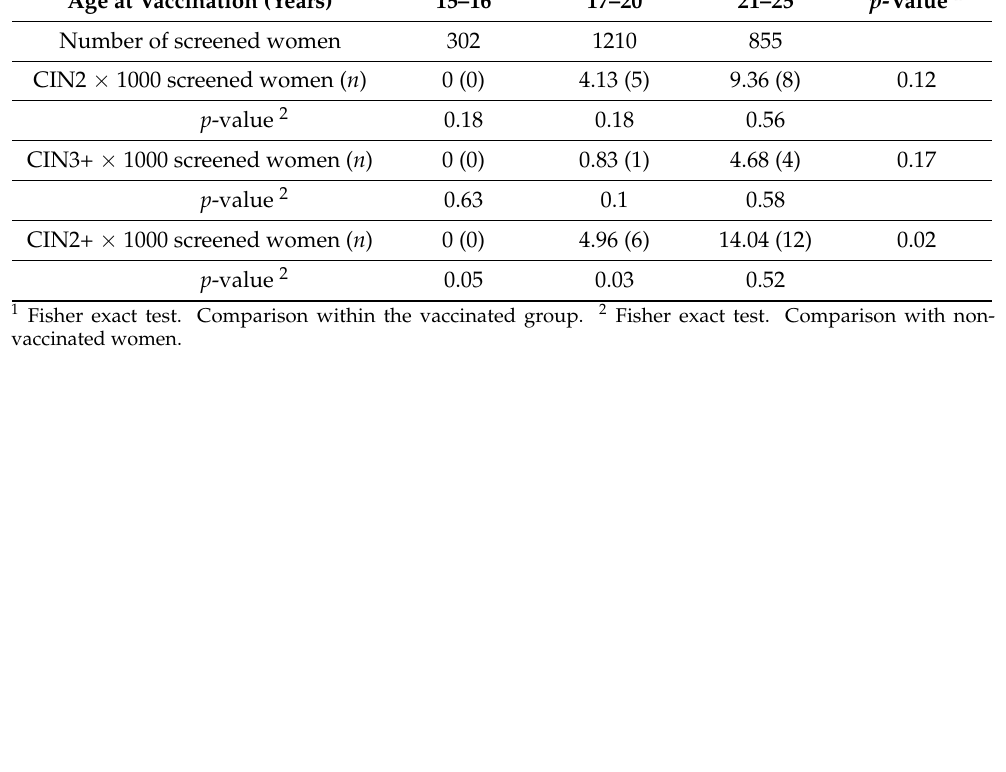
Table 2. HPV-vaccinated women: comparison of the main results according to age at vaccination. Age at Vaccination